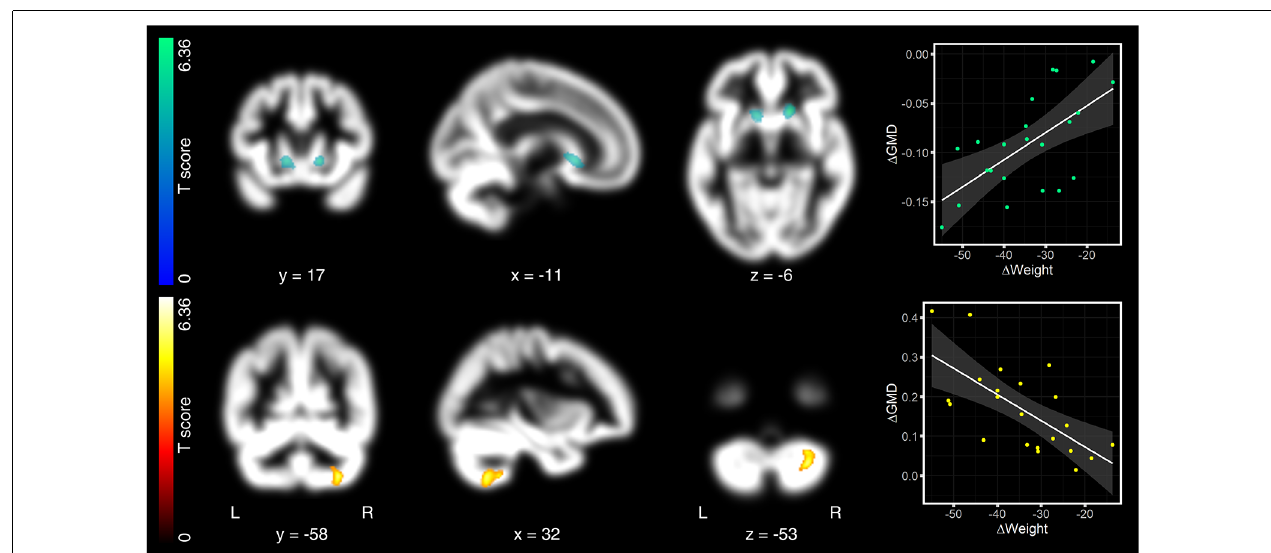
FIGURE 3 | Regression analyses between changes in GMD maps and weight, 12 months after surgery. After 12 months, the loss of body weight was associated with decreased GMD in the left caput caudate. This cluster reached peak significance level, but just missed significant cluster threshold ( p = 0.029; threshold at p = 0.025, FWE-corrected; first row). Directly opposite to this cluster, we also identified the right caput caudate, but below the significant threshold. We, nevertheless, considered both clusters together as relevant for the discussion due to the symmetry of effects. Increased GMD after 12 months was observed in the right cerebellar lobule VII (second row). As in Figure 2 , hot colors indicate positive and cold colors negative associations. Significant clusters are projected on patients’ mean GMD template, presented on a coronal, sagittal, and axial brain slice (from left to right). Coordinates below each slice index coordinates of the clusters’ peak in MNI space. “L” indexes the left, “R” the right brain hemisphere. The left-sided color bar shows the T -scores for the respective GMD cluster. Right-sided scatter plots present the association between changes in GMD and changes in body weight. As for Figure 2 , changes in GMD in the scatter plots were extracted as the 1st Eigenvariate at p = 0.025 FWE, cluster-threshold and p = 0.0005, uncorrected peak